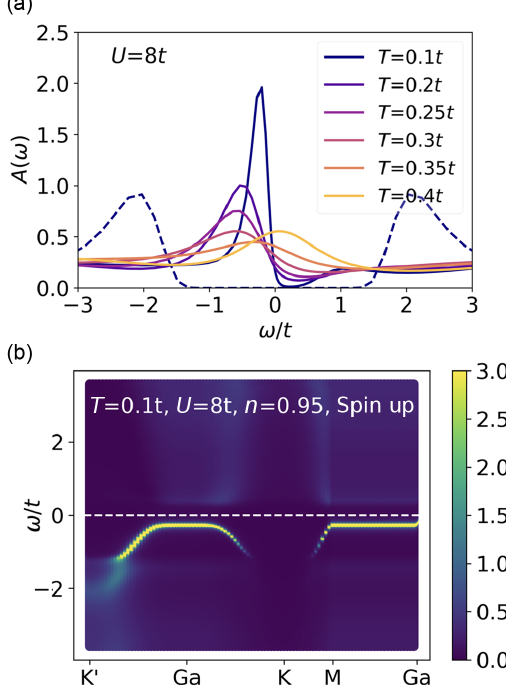
FIG. 7. (a) The momentum integrated spectral function for spin up A ↑↑ ð ω Þ at U ¼ 8 t and carrier concentration n ¼ 0 . 95 is plotted at ϕ ¼ π = 6 and different temperatures (solid line). For comparison, the spectral function for n ¼ 1 at T ¼ 0 . 1 t is shown as the dashed line. (b) The momentum-dependent spectral function A k ↑↑ ð ω Þ for spin up along a momentum line at U=t ¼ 8 , n ¼ 0 . 95 , and ϕ ¼ π = 6 . The spectral function is analytically continued from the self-energy Σ ð ω Þ using MaxEnt. The ω ¼ 0 (dashed line) corresponds to the Fermi